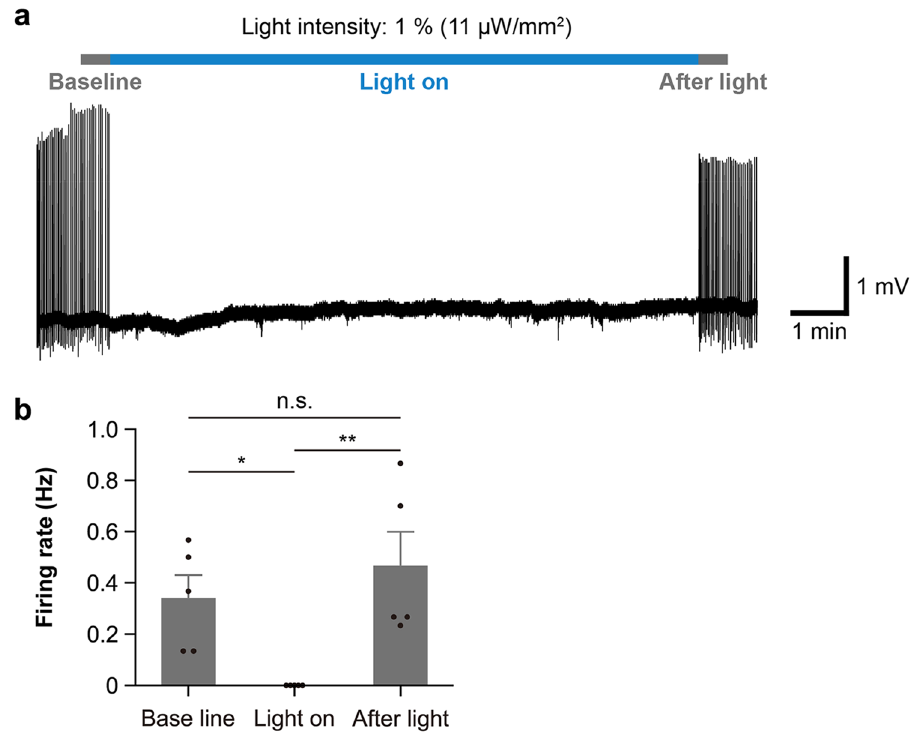
Figure 5. ACR2 continuously inhibited neuronal activity. ( a ) Representative trace of loose cell recording at 470 nm, 10 min light illumination. Light intensity was 1%, corresponding to 11 µW/mm 2 . ( b ) Comparison of the neuronal firing rate before, during, and after light illumination (n = 5 cells from an animal). ’Baseline’ and ’after light’ were defined as 30 s before and after light illumination, respectively. *p < 0.05, **p < 0.01, n.s., not significant, Tukey’s test. The bars show mean values ± SEM. The dots show individual cell